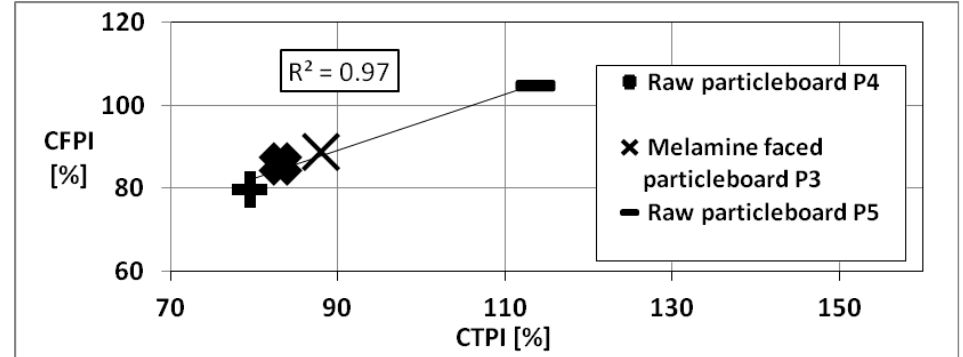
Figure 11. The relationship between the significantly reliable (CFPI) and highly simplified (CTPI) machinability indexes which were determined for